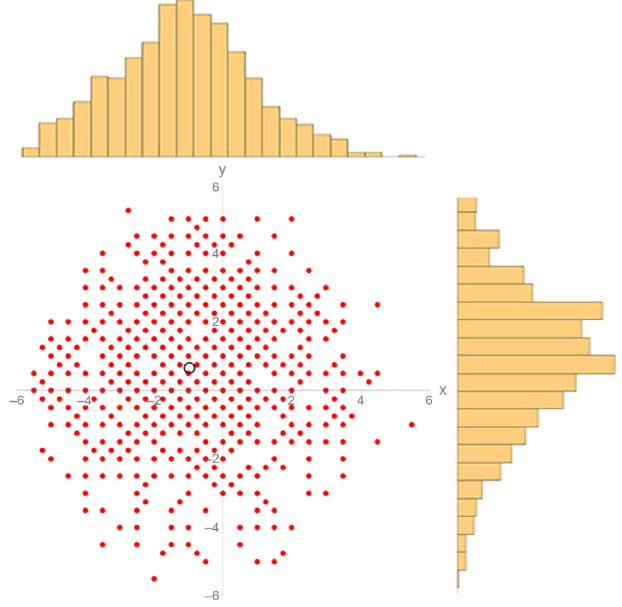
FIG. 3. The centroids of the students, the mean of the centroids (the open circle), and histograms of the centroid values.